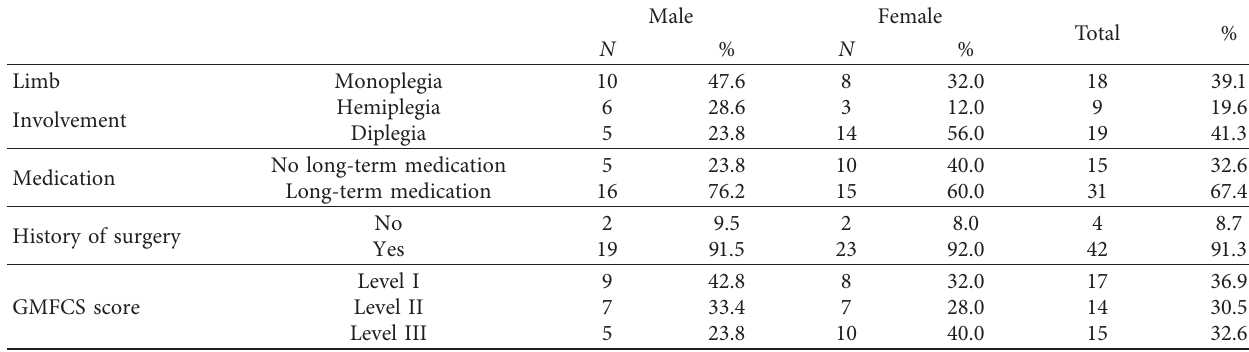
Table 1: Description of the study population.